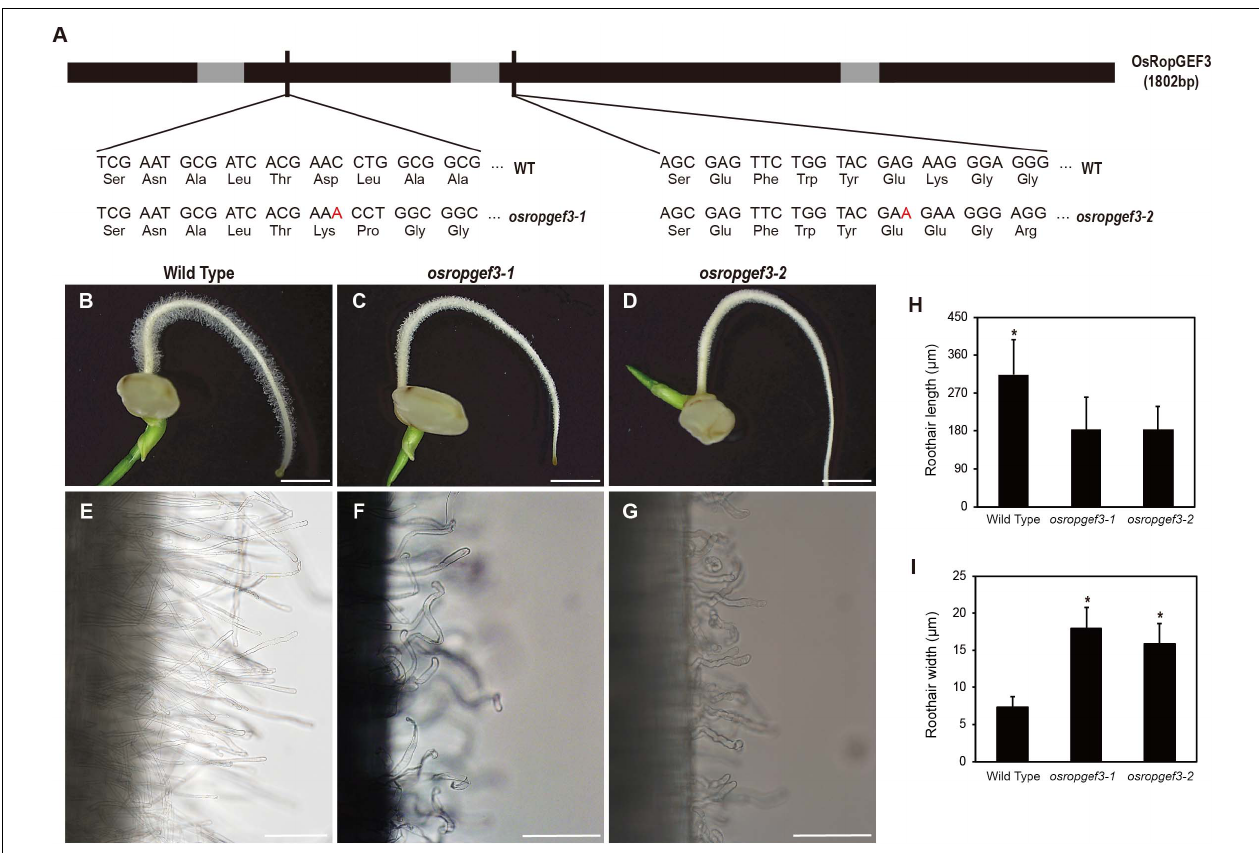
FIGURE 3 | The functional analysis of OsRopGEF3 genes using loss-of-function on rice root hairs. (A) The black bar represents the exon, the gray bar represents the intron, and the thin black bar represents the gRNA target point for the mutant line. OsRopGEF3 genomic DNA has 1802 base pairs. The first loss-of-function mutant ( osropgef3-1 ) designated the front of the second exon as the gRNA target site, and the second mutant ( osropgef3-2 ) designed the target in the third exon. In both mutant lines, one base (adenine) was inserted, and subsequently, both amino acid sequences were broken, and there was no stop codon produced. (B–G) Phenotypic analysis in 3 days after germination loss-of-function transgenic plants. Bars = 3 mm (B–D) and 100 µ m (E–G) . (H,I) The root hair length and width comparison between the wild-type and osropgef3 mutant. The length and width of the root hairs were quantified 2–8 mm from the root apex. The average was calculated by measuring at least 100 root hairs per plant. Error bars represent standard errors in six biological replicates. Significant differences are indicated by asterisks, * p < 0.05. The data were analyzed using Student’s t